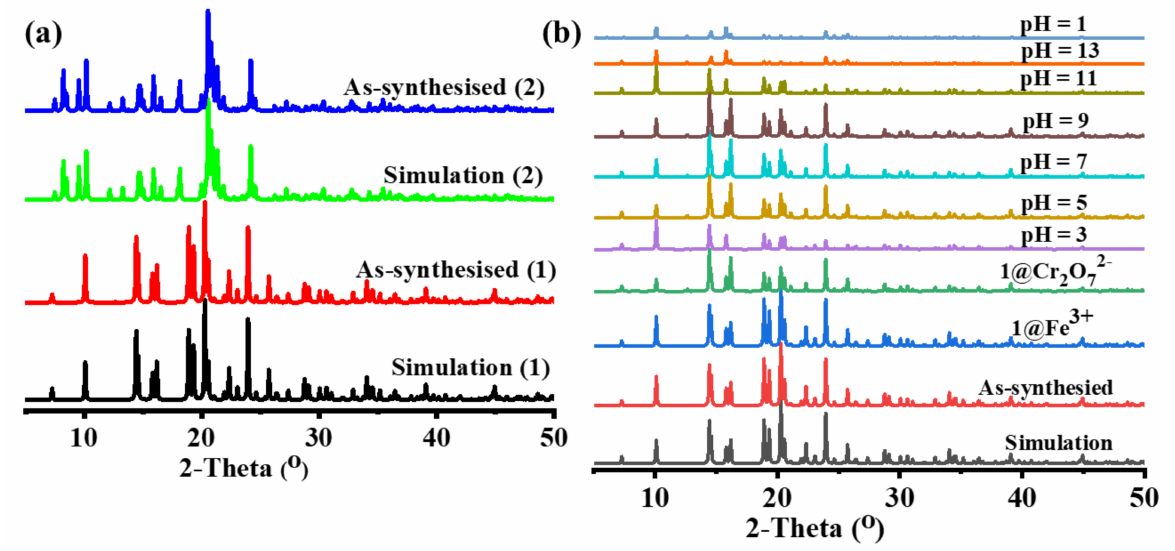
Figure 12. ( a ) PXRD profiles of the as-synthesized 1 and 2 , and the simulated result as reference. ( b ) PXRD profiles of the as-synthesized 1 and the simulated result as reference as well as luminescence sensing analytes, and 1 after dispersed pH = 1–13 aqueous solution.